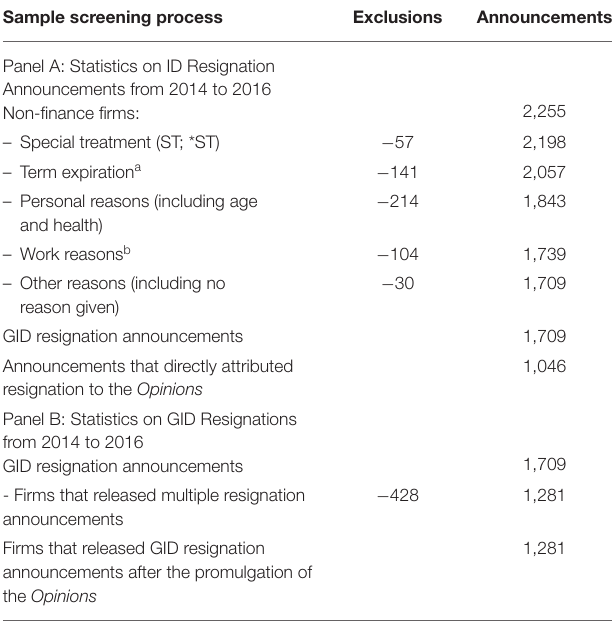
FIGURE 2 | The treatment effect for evaluation of DID model.